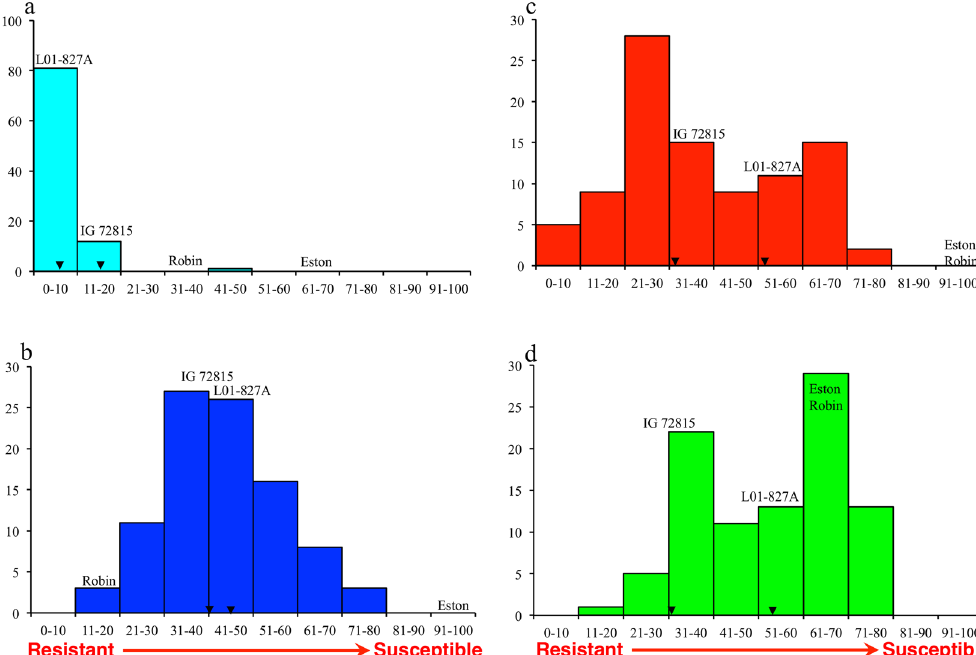
Figure 1. Frequency distributions of disease reactions in the Lens ervoides recombinant inbred line population LR-66 developed from L01–827A × IG 72815 (F 9 ) following inoculation with Ascochyta lentis isolate AL61 ( a ), Colletotrichum lentis isolates CT-21 (race 1, b ) and CT-30 (race 0, c ), and Stemphylium botryosum isolate SB19 ( d ). Arrow heads indicate the least squares means of disease reactions on parental accessions. Lens culinaris cultivars Eston and CDC Robin are susceptible and resistant L. culinaris checks,